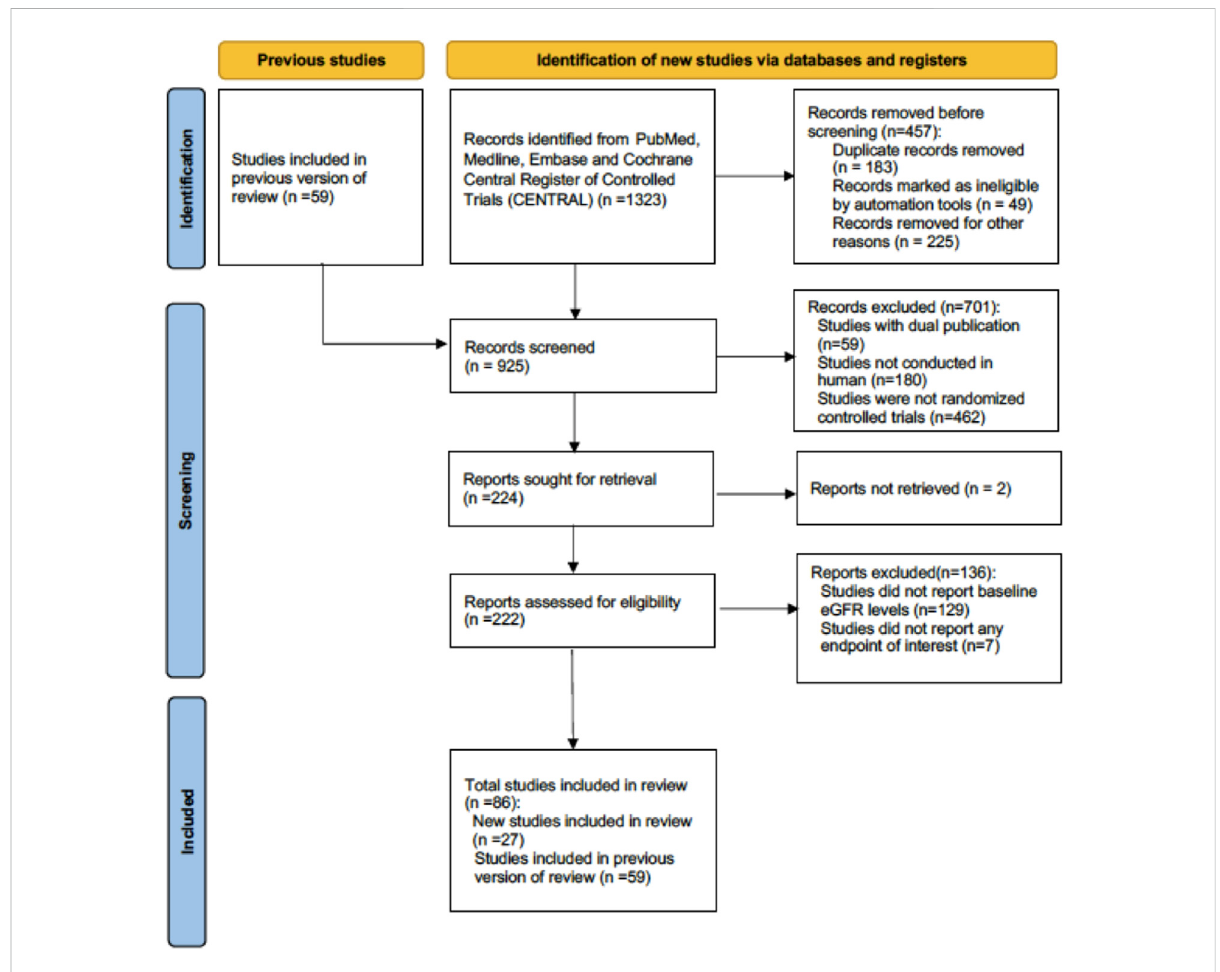
FIGURE 1 Flowchart of the included